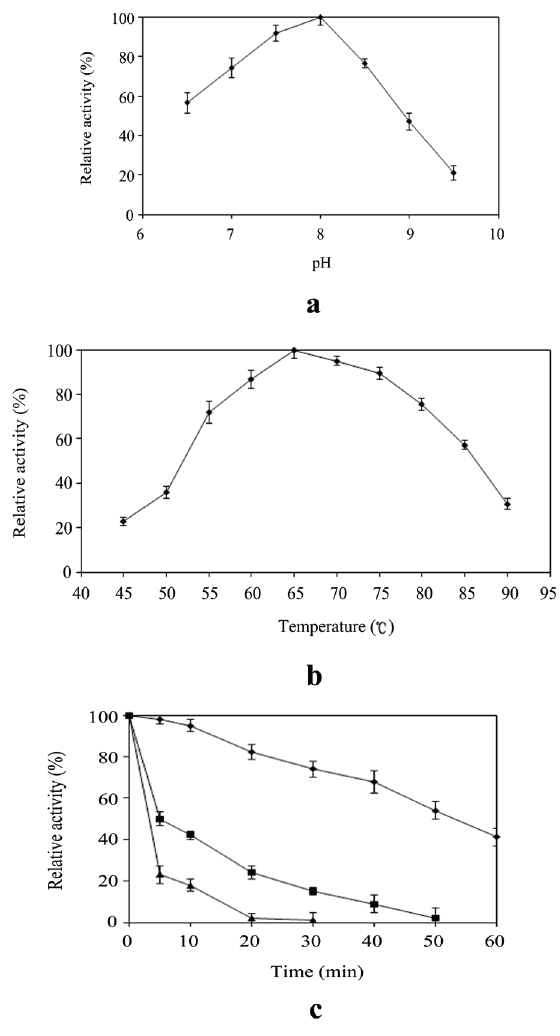
Figure 4 - Biochemical characterization of StoNurA. ( a ) Effect of pH on the purified StoNurA. Optimal pH of StoNurA at pHs ranging from 6.5 to 9.5 was measured for 30 min at 65 °C. ( b ) Effect of temperature on the purified StoNurA. Optimal temperature of StoNurA was determined with the ssDNA as substrates in 20 mM of HEPES buffer (pH 8.0) at different temperatures ranging from 45 to 90 °C. ( c ) Thermostability of StoNurA. The residual enzyme activity was measured after incubation of the purified enzyme at 80 °C (diamonds), 90 °C (boxes), and 100 °C (triangles), respectively. Each value was calculated based on the results of three independent